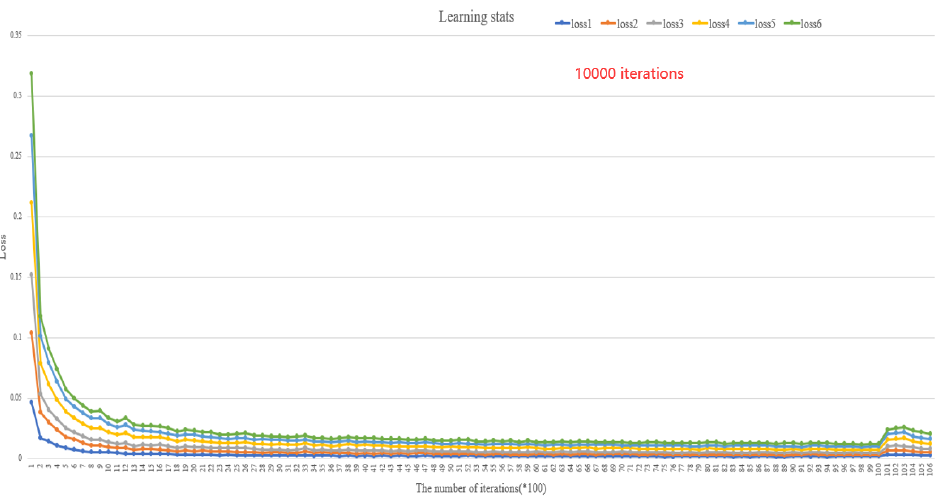
Figure 7. Light attention DeepLab V3+ network structure.